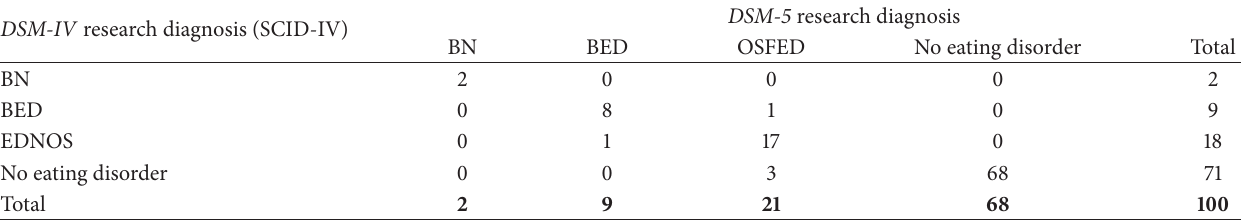
Table 2: DSM-IV versus DSM-5 eating disorder diagnoses conferred by structured interviews in an outpatient weight-loss seeking sample. DSM-IV research diagnosis (SCID-IV)